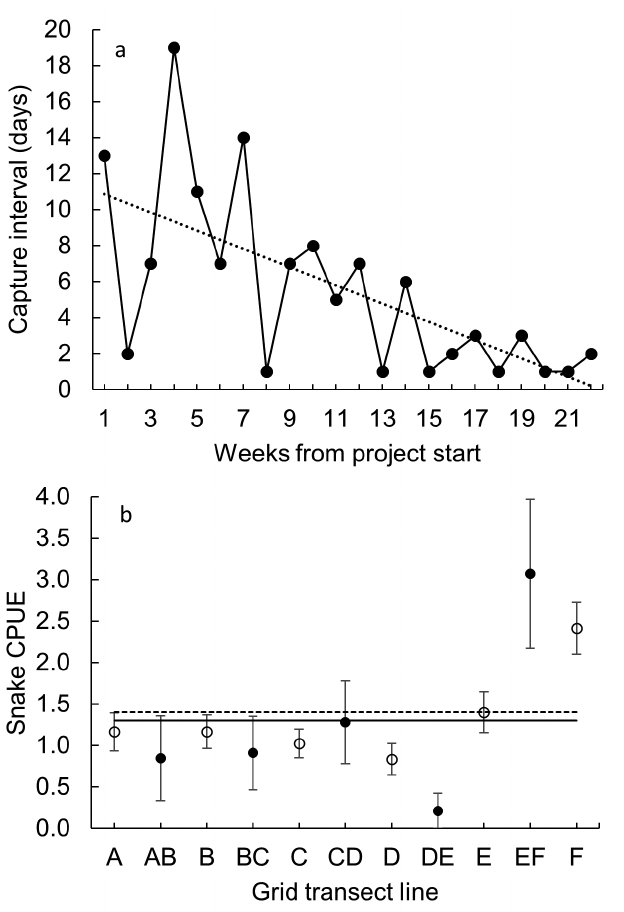
Figure 4. We observed temporal ( a ) and spatial ( b ) effects on brown treesnake captures at bird- and mouse-lure traps (note: graphs do not include camera data). Capture intervals (days between capturing any snake in a bird-lure trap) decreased as length of time from study start date increased ( a ). Catch per unit effort (CPUE, snakes/100 trap nights) was greater for bird-lure (closed circles) and mouse-lure (open circles) transects that were closer to the cliff-line (E–F; see b ). In panel b, the solid black line indicates mean bird-lure trap CPUE and dashed line is mean mouse-lure trap CPUE from this